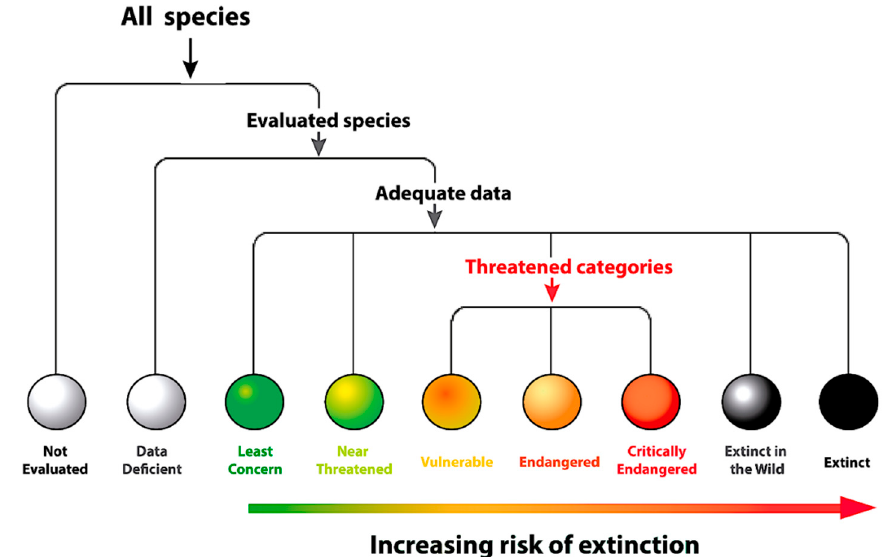
Figure 17. International Union for Conservation of Nature (IUCN) categories of species conservation status.